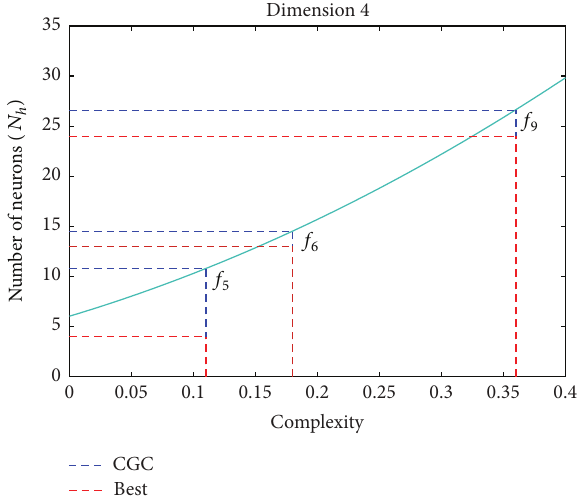
Figure 4: The model constructed for 𝑁 = 4 input dimensions and its application to estimate an adequate size neural network for three test benchmark functions. The continuous line represents the model estimated from a set of trigonometric functions of variable complexity and the blue dashed line indicates the size estimated by the model (using the 𝑌 -axis values), while the red dashed line is the best size obtained from exhaustive numerical simulations.